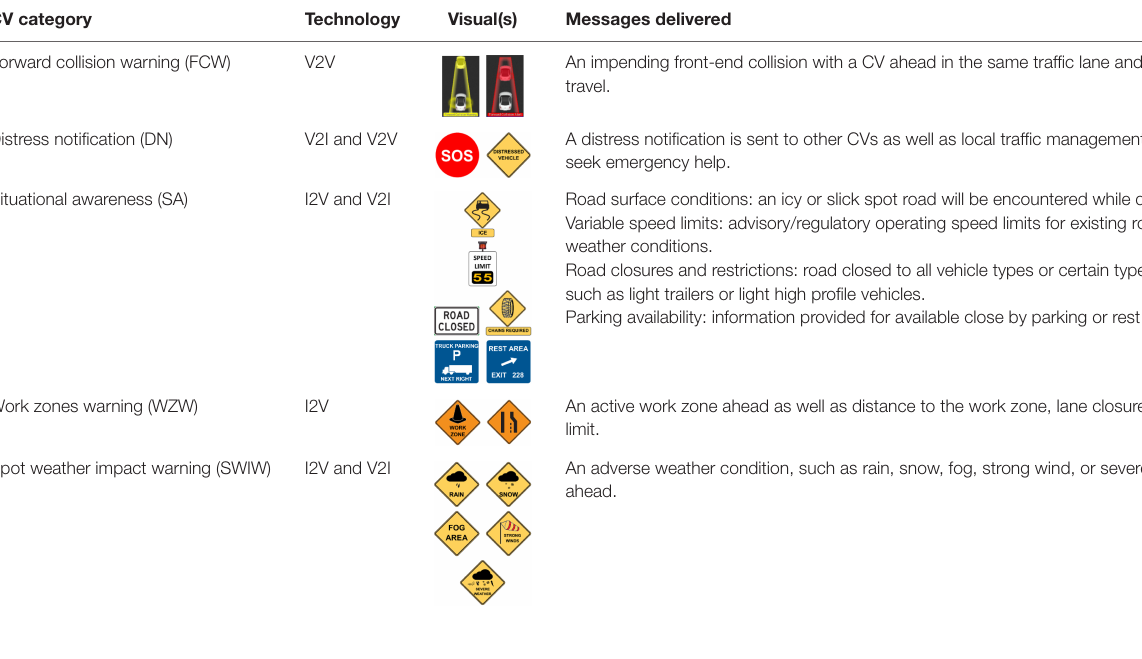
TABLE 1 | Summary of the Wyoming CV